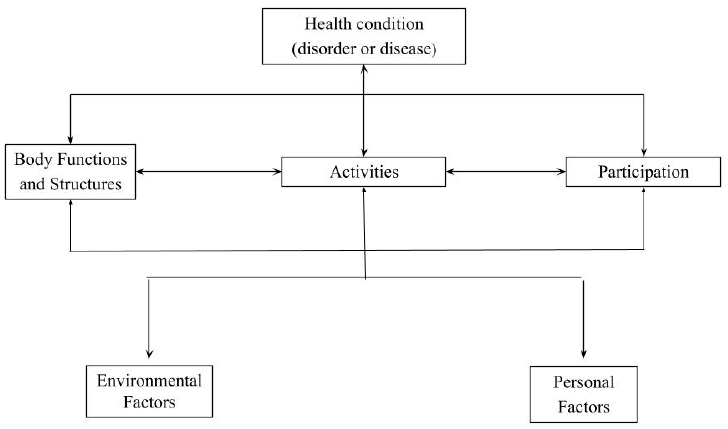
Figure 1. ICF Model: Interactions between the components Adapted [8].